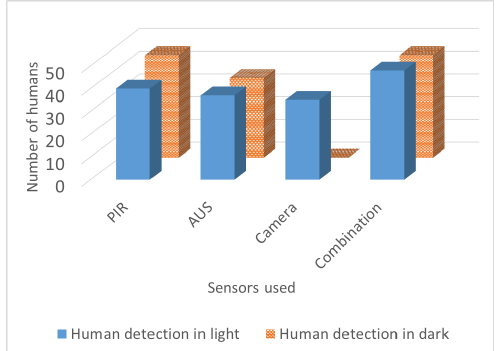
Figure 8. Number of human correctly classified (total number = 45)